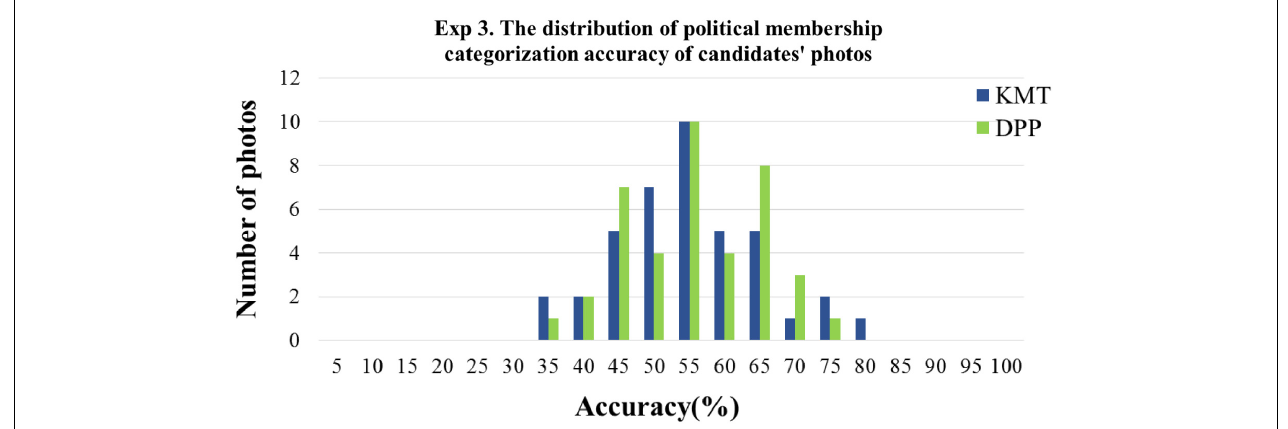
FIGURE 5 | The distribution of item difficulties in Experiment 3, measured by the percentage correct collapsed across participants. The abscissa denotes the categorization accuracy of the candidates’ photos in 5% bins; the ordinate denotes the number of photos.